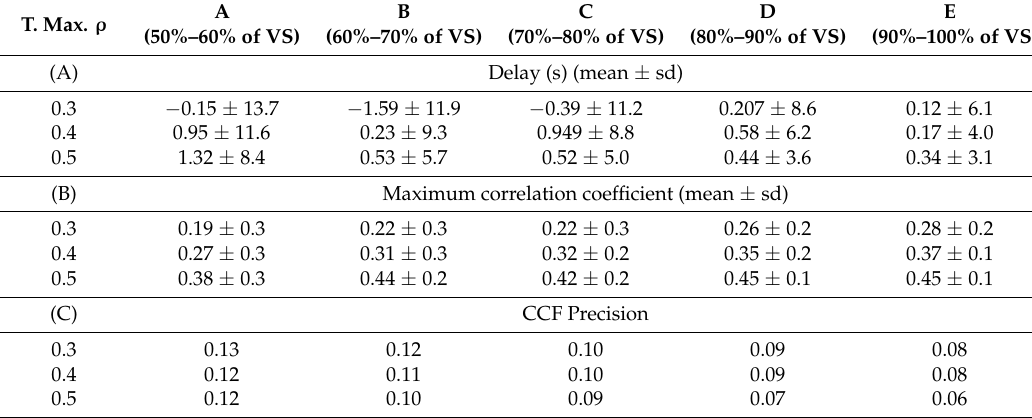
Table 2. Correlational analysis for simulated data with different MDS distribution. ( A ) Results for time delay of maximum correlation coefficient; ( B ) Results for maximum correlation coefficient; ( C ) Cross-correlation function (CCF) precision (mean value of standard deviation of CCF with respect to target value, for each time shift). The results are shown for different target maximum correlation coefficients (T. Max. ρ